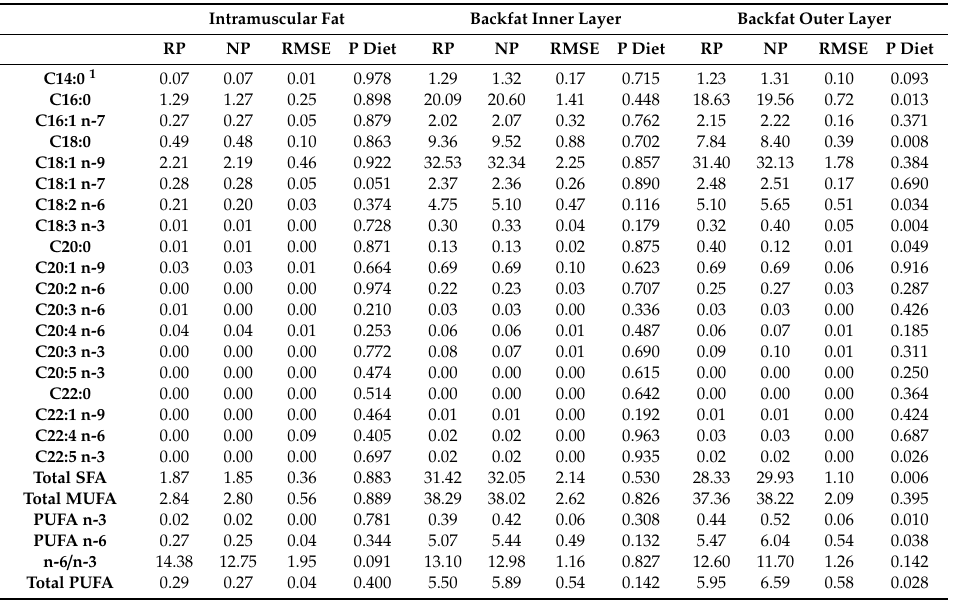
RP: restricted protein group; NP: normal protein group; significance level was stated at p < 0.05. Single FAs were expressed as g / 100 g of tissue (lean or backfat layers). 2 Trace amounts of the following FAs were also